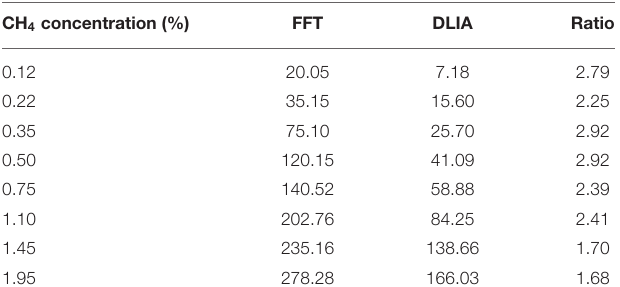
TABLE 1 | Comparison of 2 f signals SNR extracted by FFT and DLIA demodulation algorithm. CH 4 concentration (%) FFT